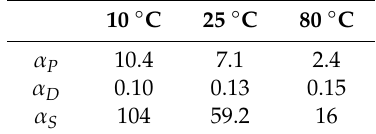
Table 6. Selectivity of butane / methane for PMPentyne.